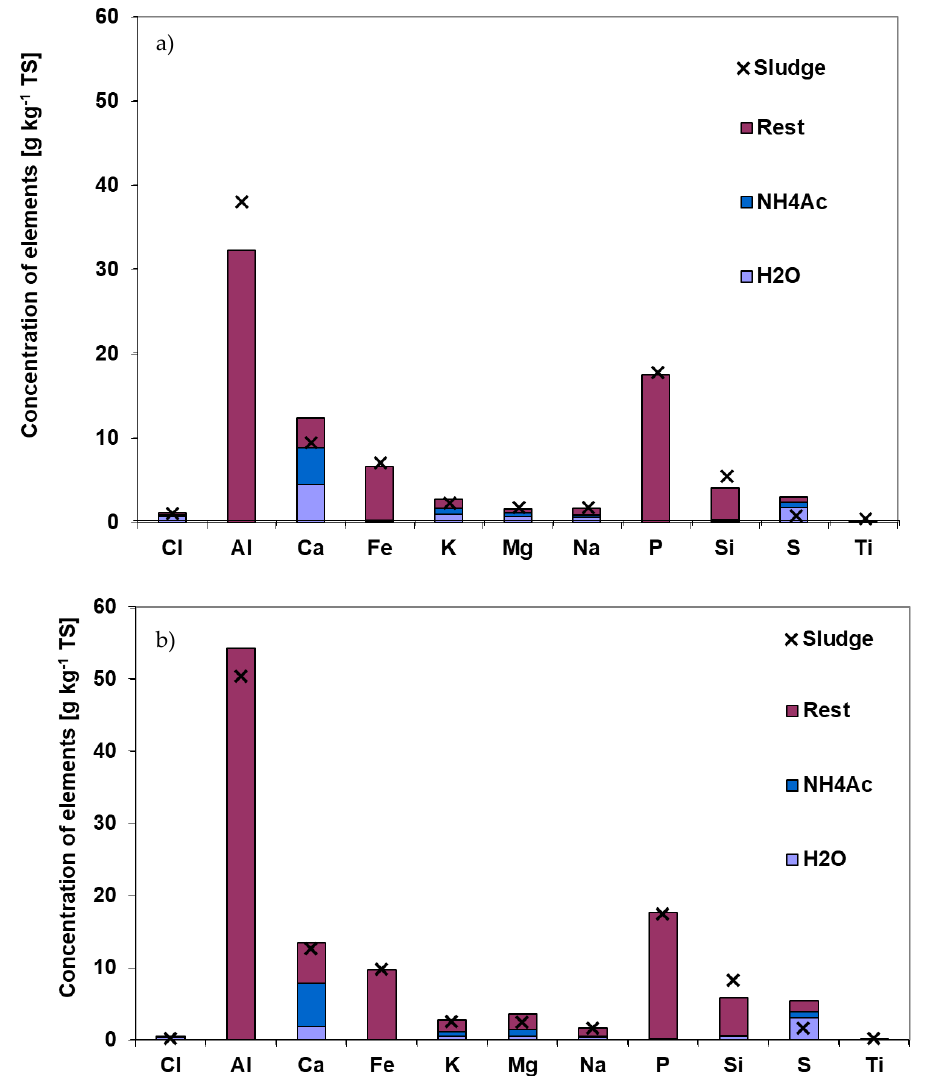
Figure 8. Results of the chemical fractionation of sewage sludge (main elements) in g kg −1 TS. Crosses (X) represent the total concentration of the element in the sewage sludge ( a ) LSS and ( b ) BSS.